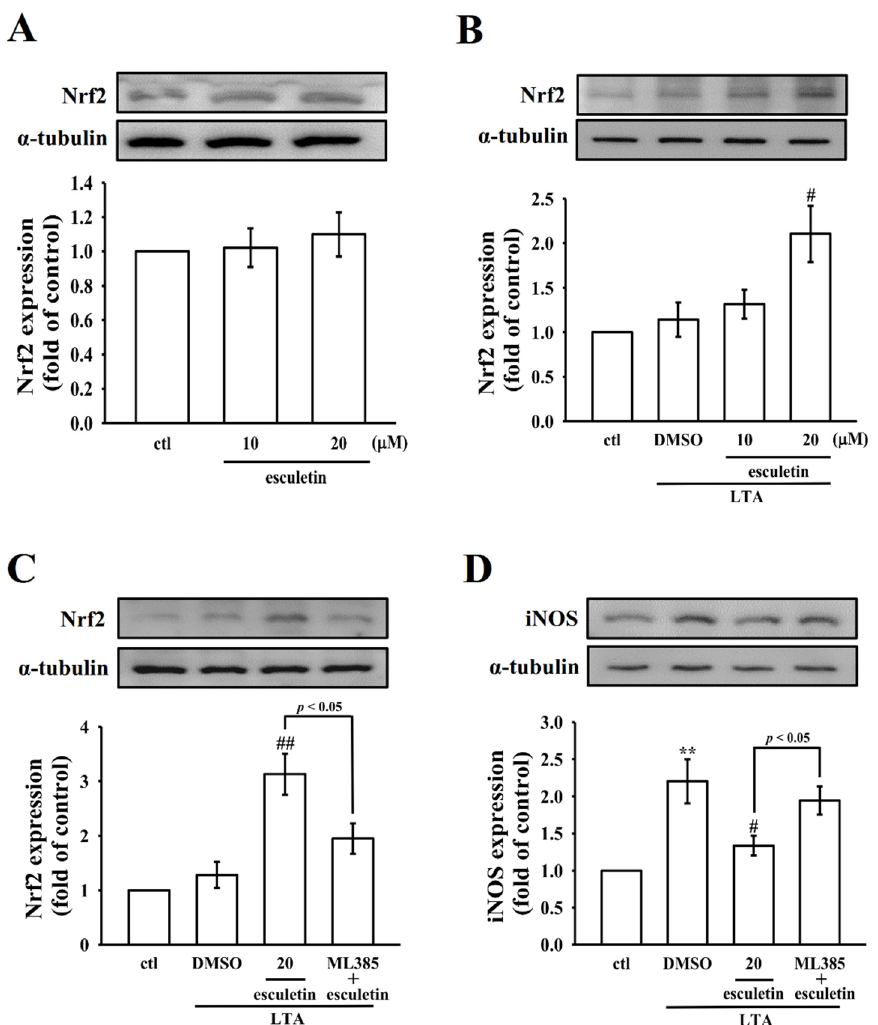
Figure 5. Esculetin enhances antioxidant defense molecules Nrf2 in LTA-induced RAW cells. Cells were treated with ( A ) 0.1% DMSO or esculetin (10 and 20 µM) alone, and ( B ) treated with 0.1% DMSO or esculetin (10 and 20 µM) for 1 h followed by LTA (10 µg/mL) for 24 h. ( C , D ) Cells were